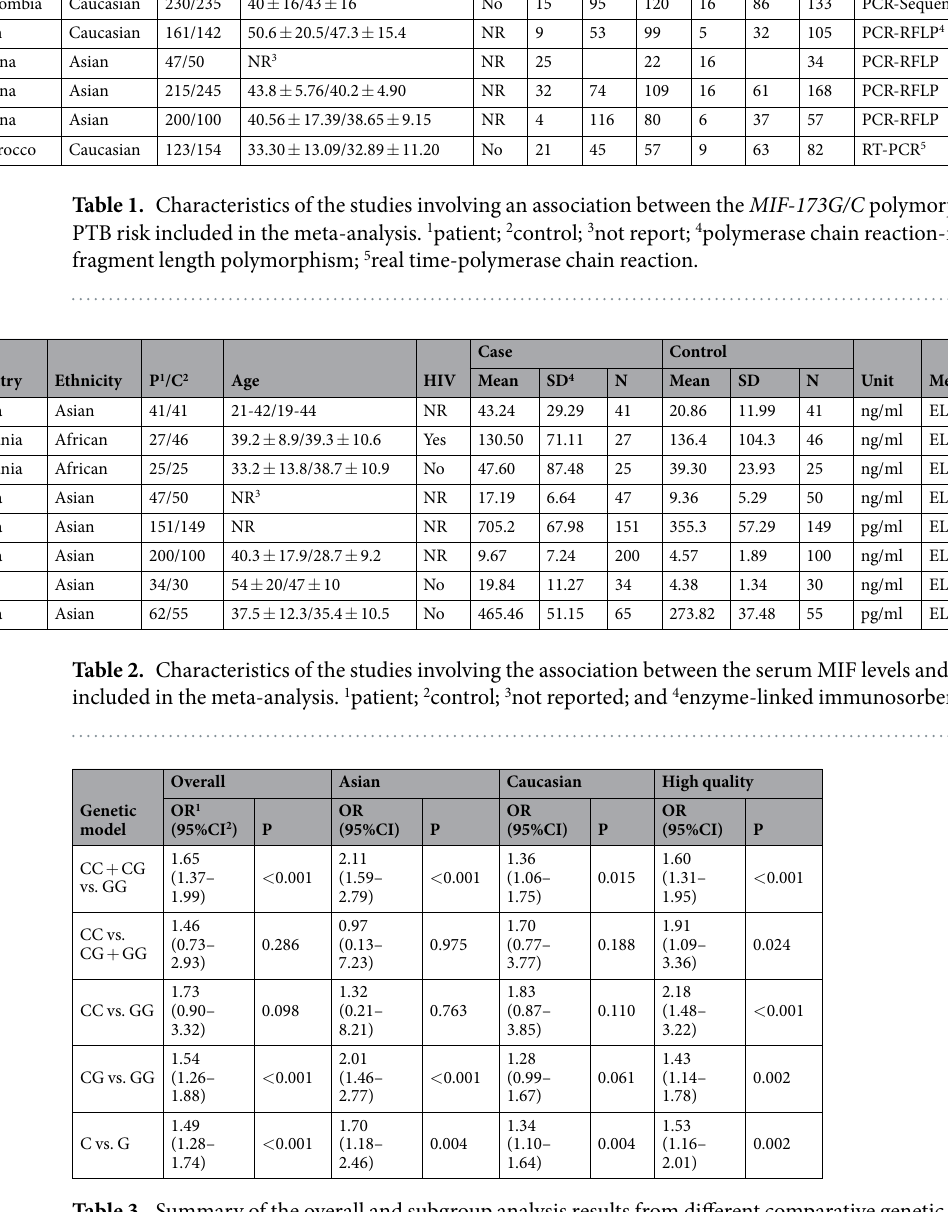
Table 3. Summary of the overall and subgroup analysis results from different comparative genetic models. 1 odds ratio and 2 confidence